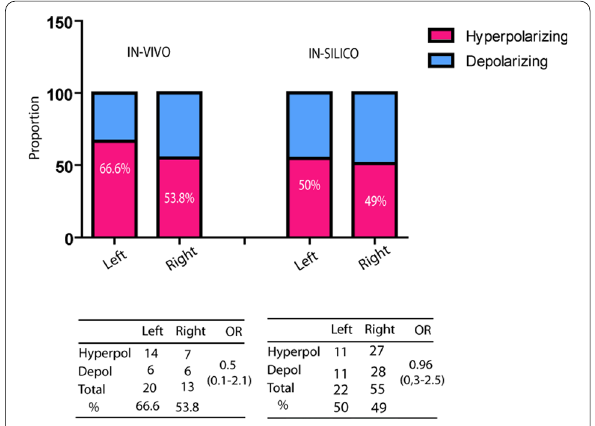
Fig. 2 L–R comparison of methylated hyper vs depolarizing ion channels. Data from in-vivo and in-silico analyses. Tendency shows in both approaches R-sided tumors with subtle decreased proportion of methylation in hyperpolarizing channels, as compared to L ones (53.8% vs 66.6% in-vivo; 49% vs 50%